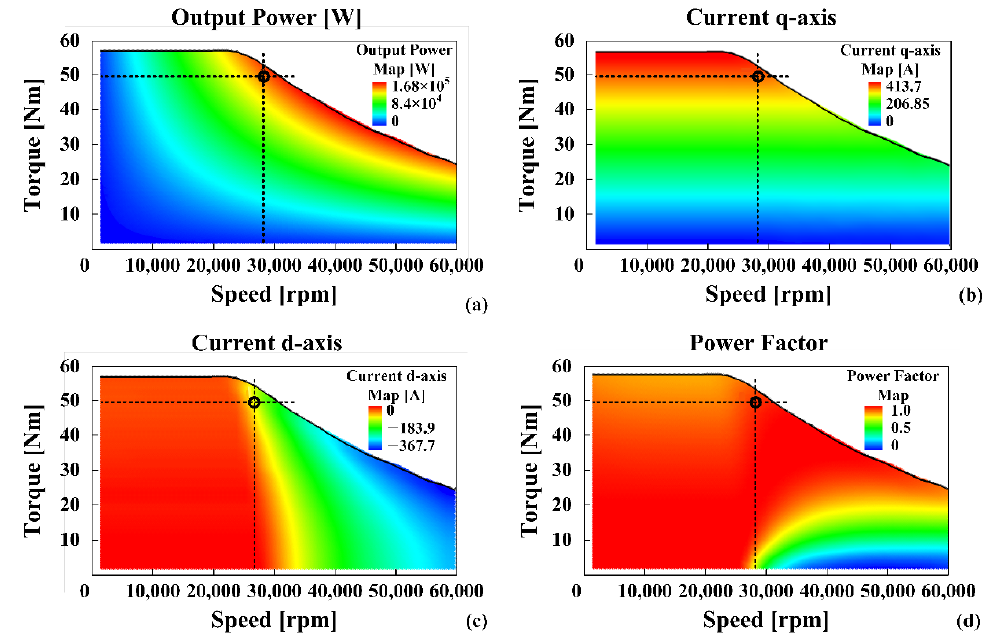
Figure 5. Operating performance results of titanium material shaft motor: ( a ) output power, ( b ) iq, ( c ) id, and ( d ) power factor.